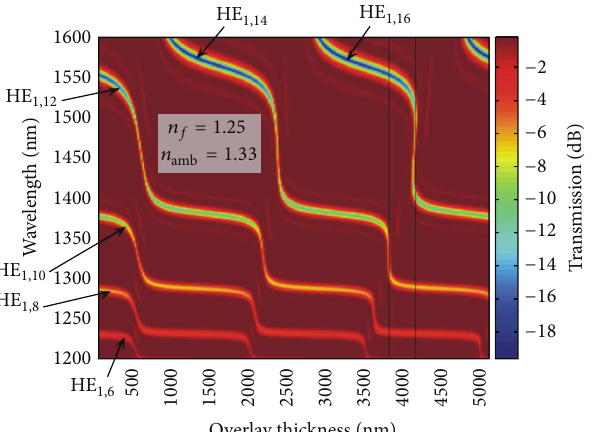
Figure 13: Higher order transitions (taken from [50]).